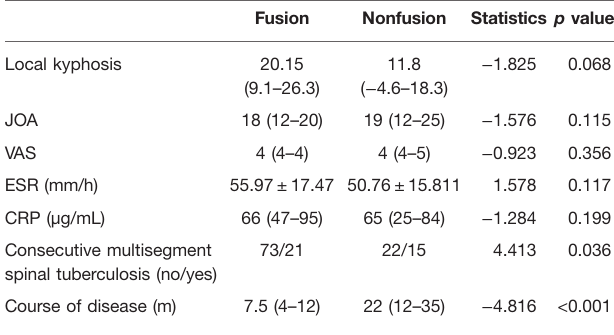
TABLE 2 | Comparison of preoperative data between the two groups.